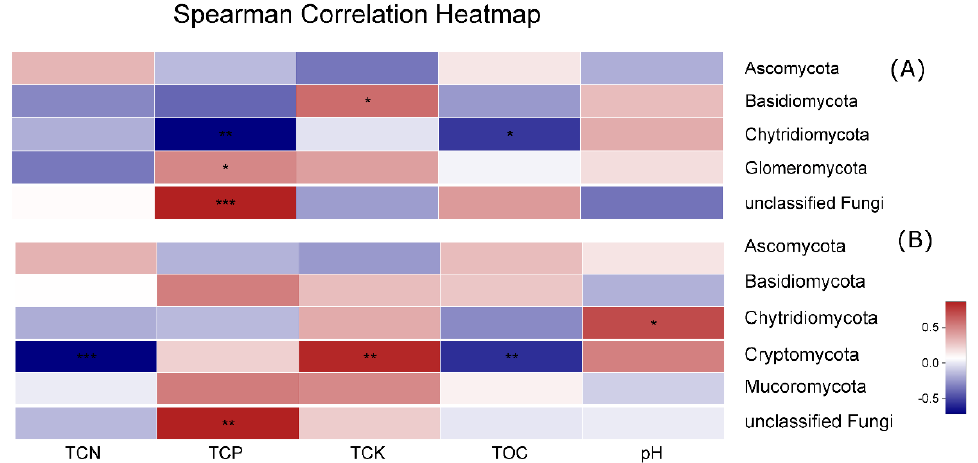
Figure 8. The heatmap of the correlation between fungal phyla and physicochemical characteristics of rhizospheric soil ( A ) in winter and ( B ) in summer. This heatmap was created according to the result of Spearman’s correlation analysis. Positive relationships are represented in red, while negative relationships are represented in blue. The significant correlations are presented as asterisks (*, p < 0.05; **, p < 0.01; ***, p < 0.001).